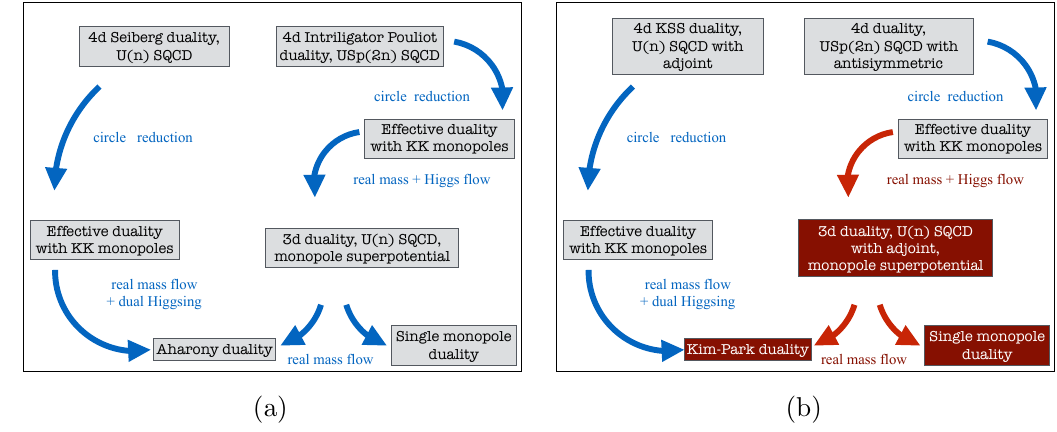
Figure 1 . In (cid:12)gure (a) we represented two di(cid:11)erent strategies, appeared in the literature, that starting from 4d dualities led to Aharony duality. In the (cid:12)rst case one starts from Seiberg dual- ity [41], reduces on the circle obtaining a new e(cid:11)ective duality [22] and then, by a real mass (and a Higgs (cid:13)ow in the dual phase), one recovers Aharony duality [42]. In the second case one starts from the duality of [43], reduces on a circle and then (cid:13)ows to a new duality [23], in the presence of monopole superpotentials. It is then possible to either (cid:13)ow to the duality with a single term in the monopole superpotential or to the conventional Aharony duality by a real mass (cid:13)ow. In (cid:12)gure (b) we discussed the same type of reductions for theories with two-index tensorial matter. The